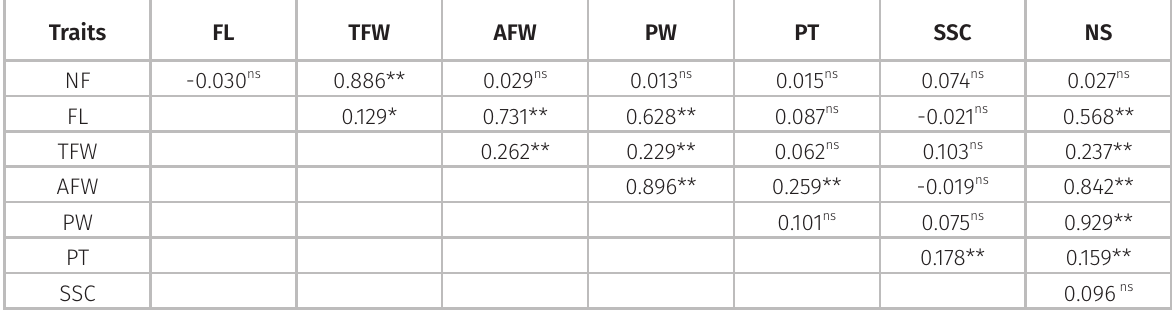
Table III. Estimates of phenotypic correlations for number of fruits per plant (NF), fruit length (FL), total fruit weight (TFW), average fruit weight (AFW), pulp weight (PW), peel thickness (PT), soluble solids content (SSC)